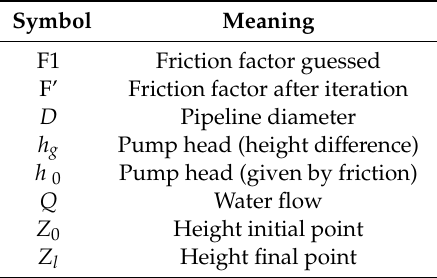
Table A6. Symbols used in